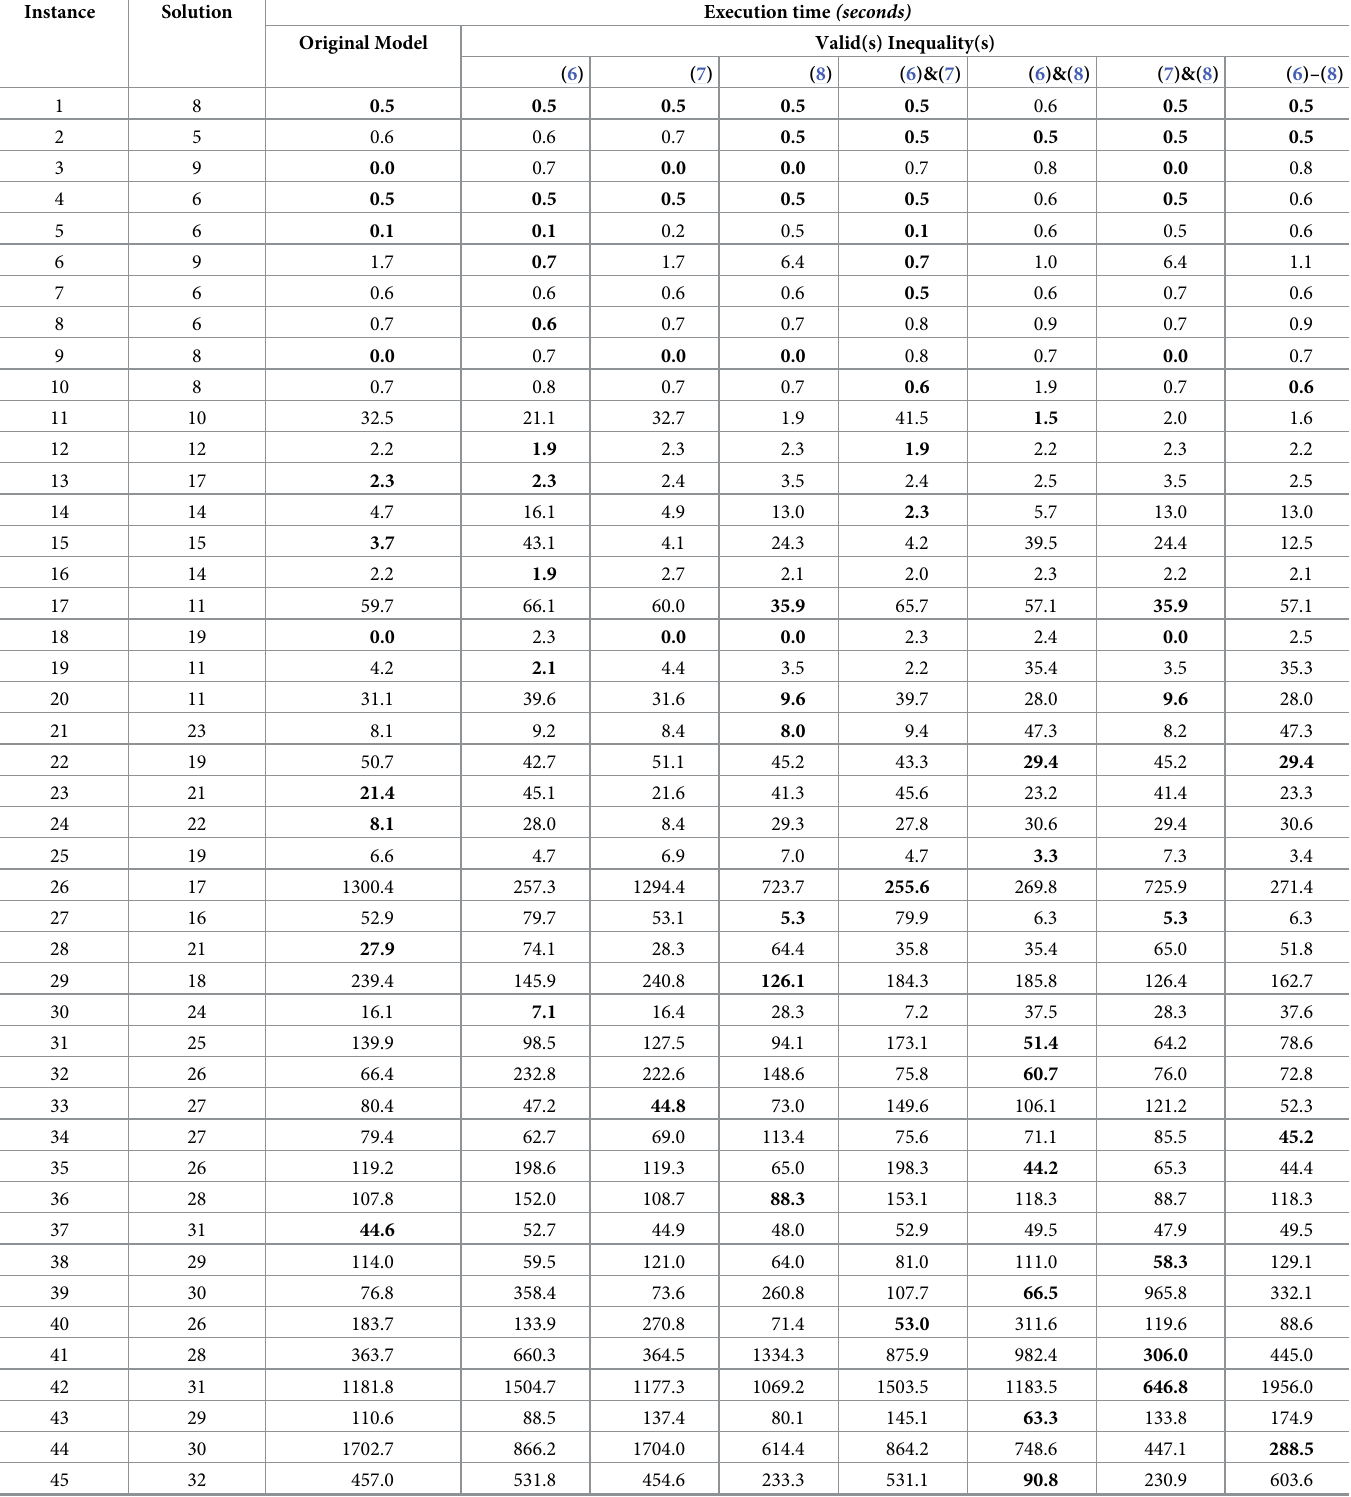
Table 5. Experimental results for Class 1 of the bwmv instances without rotations, applying the different families of valid inequalities to the set-covering ILP.